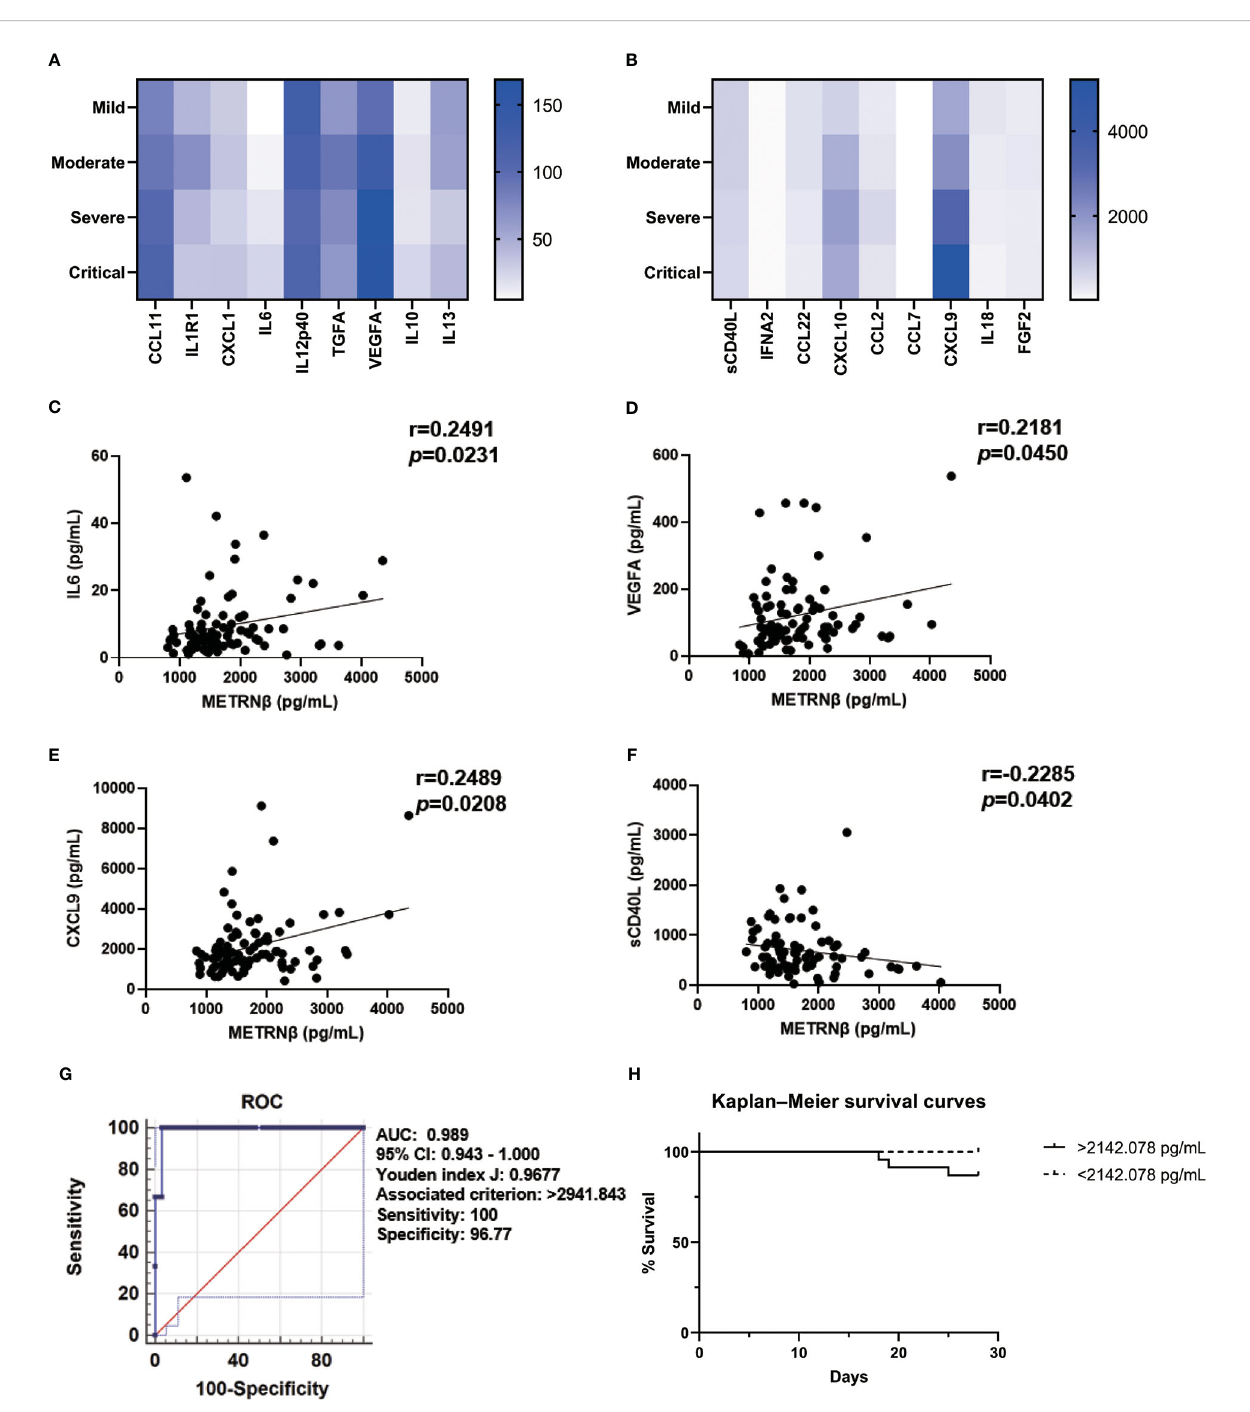
FIGURE 4 Validation of METRN b as a surrogate prognostic biomarker for COVID-19. (A, B) Longitudinal cytokine/chemokine pro fi le of COVID-19 patients (n = 81 – 96) with the human Cytokine Milliplex MAP assay kit. The results were shown as heat maps. (C – F) Correlation analysis of serum METRN b concentration with IL6 (n = 83), VEGFA (n = 85), CXCL9 (n = 86) and sCD40L (n = 81). Spearman ’ s correlation coef fi cient was used for correlation analysis. (G) ROC of serum METRN b at admission to distinguish non-survivors from survivors. The AUC was 0.989 (95% CI: 0.943 – 1.000) for serum METRN b levels on admission in the validation cohort of COVID-19 patients with non-Omicron-SARS-CoV-2 infections (n = 96). (H) Kaplan-Meier survival curves of COVID-19 patients with non-Omicron-SARS-CoV-2 infections in the validation cohort based on the METRN b cutoff value (2142.078 pg/mL) calculated from the prediction cohort. AUC: area under the